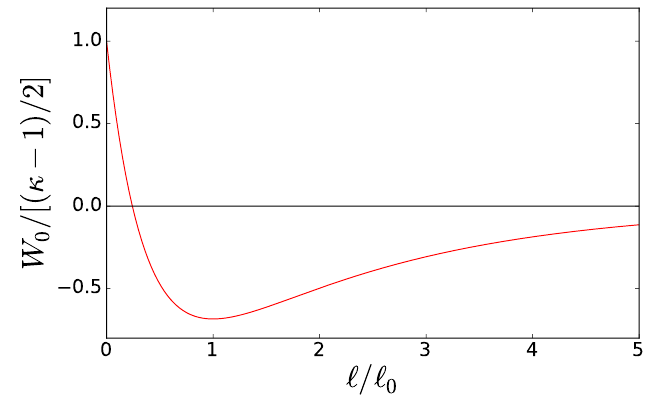
, the equilibrium 0